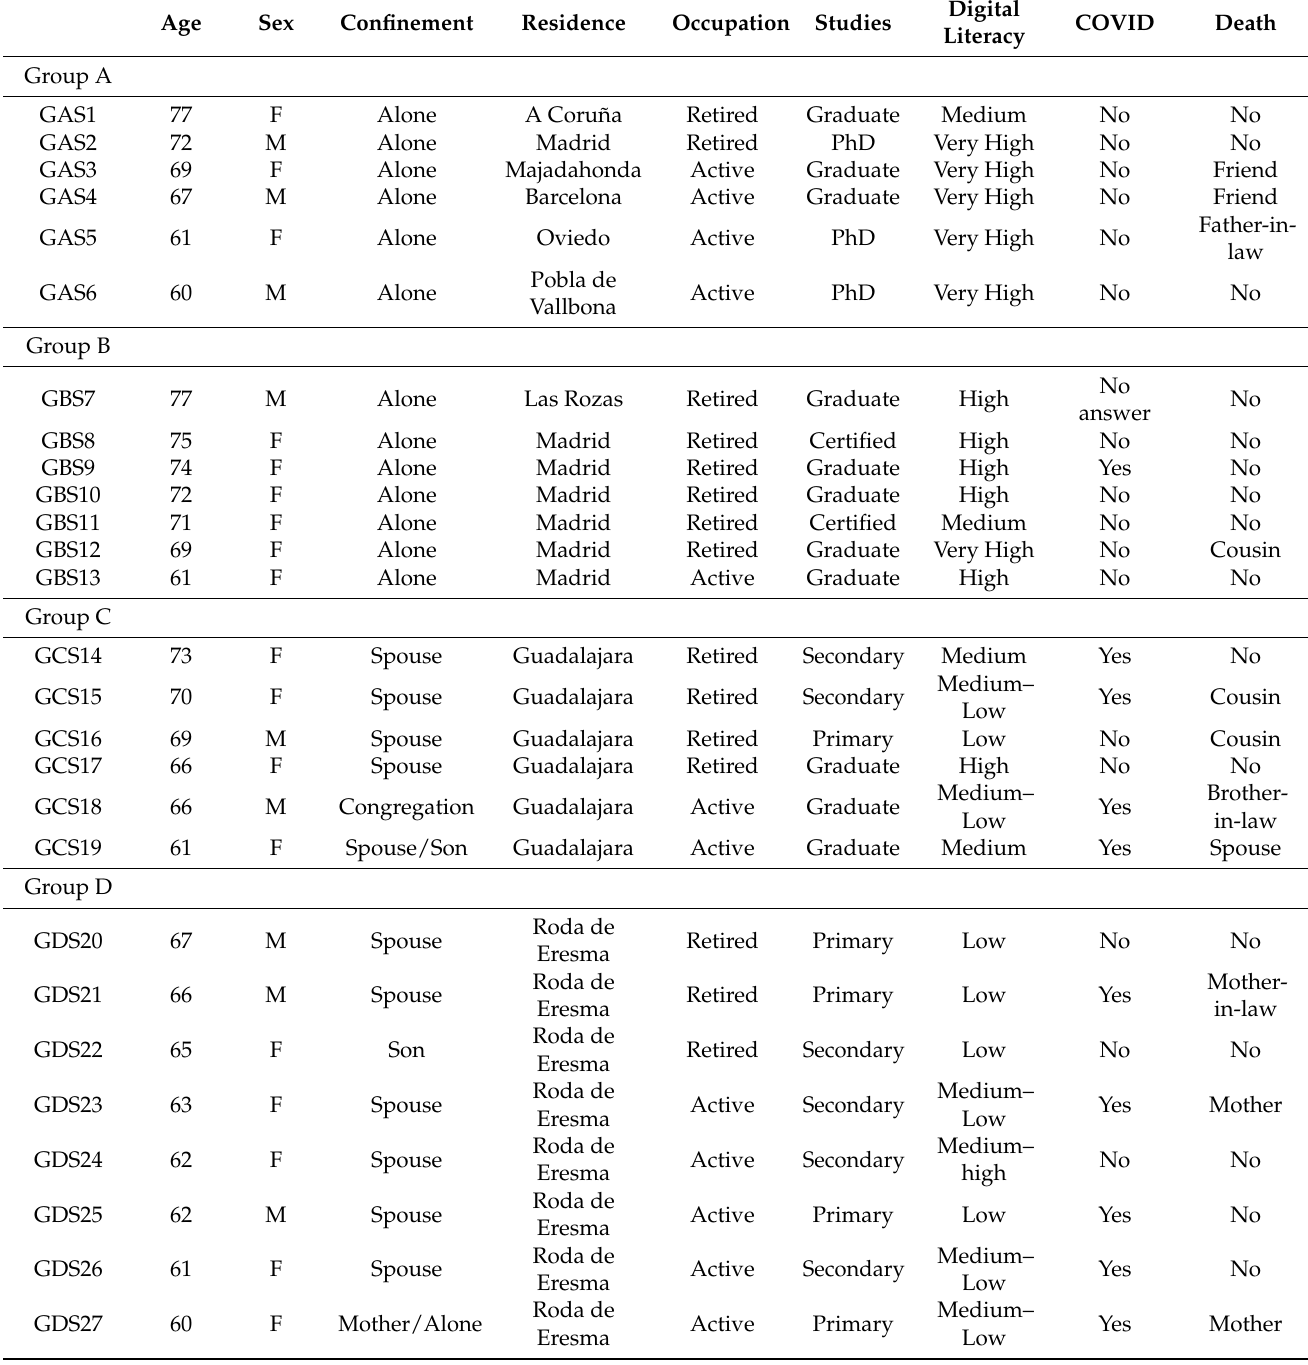
Table 1. Focus groups setting ( n =